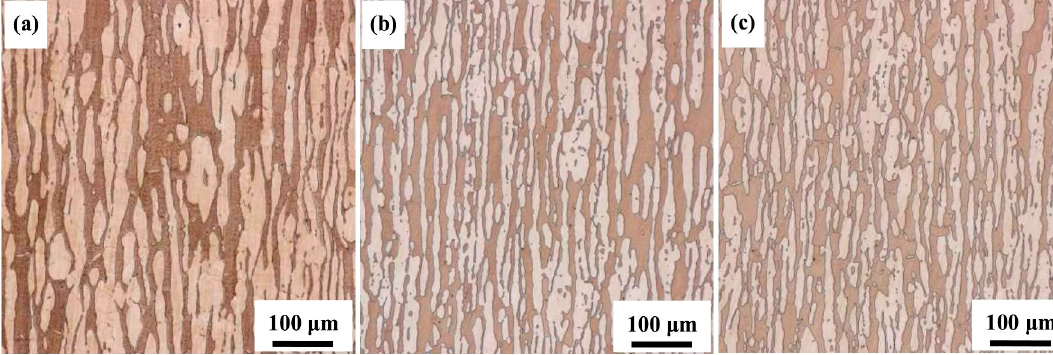
Figure 5. Metallographic microstructures of the 0#–2# experimental samples: ( a ) 0#; ( b ) 1#; ( c ) 2#. Table 7. Proportions of two phases of the 0#–2# experimental samples.